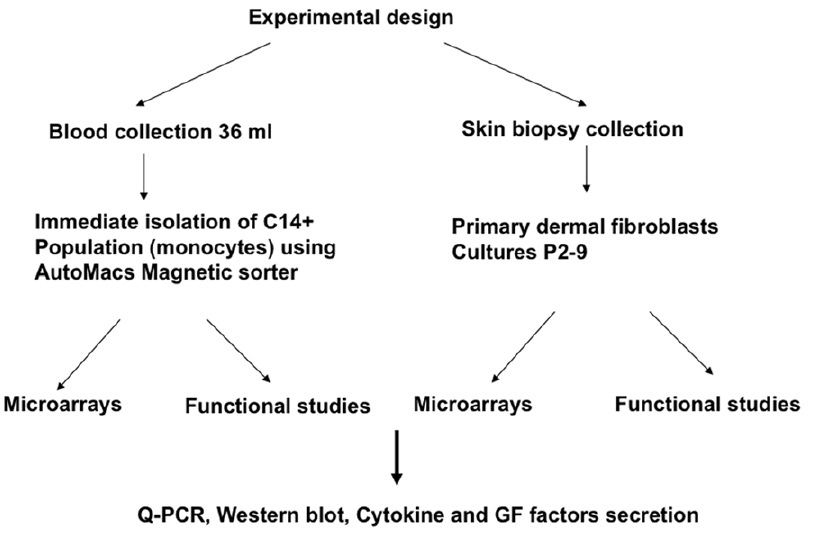
Figure 1. Experimental design. Collection of monocyte fractions and culture of primary dermal fibroblasts for the evaluation of gene expression and functional differences between CHM patients and age-matched